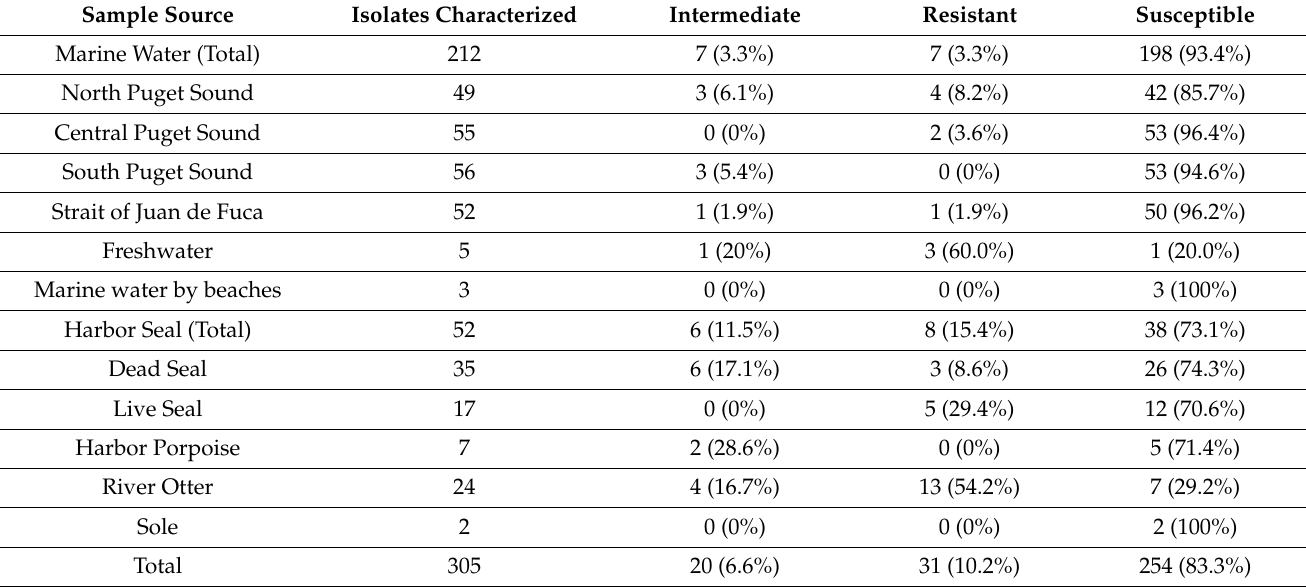
Table 1. Total number of isolates characterized and antibiotic-susceptibility testing results for each source. Sample Source Isolates Characterized Intermediate Resistant